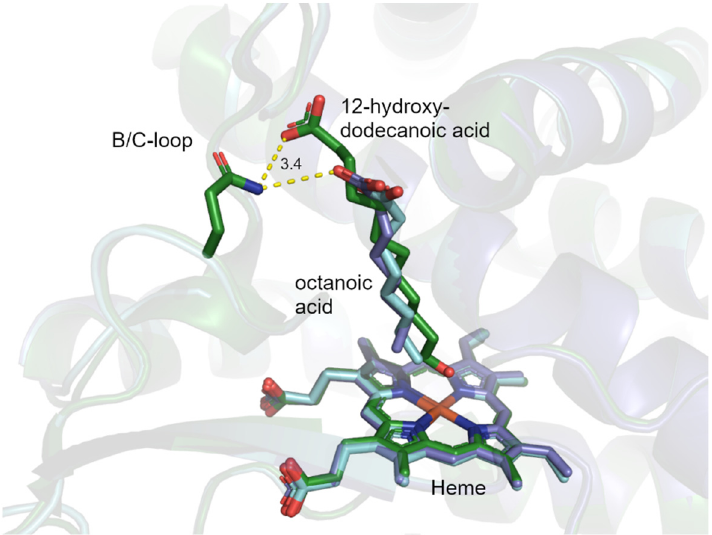
Figure 8. Overlay of CYP153A71 chain A (purple), chain B (blue), and CYP153A33 (green, 5FYG) showing the coordination of the carboxyl group of octanoic acid in CYP153A71 and 12 ‐ hydroxydodecanoic acid in CYP153A33 by the conserved Gln.